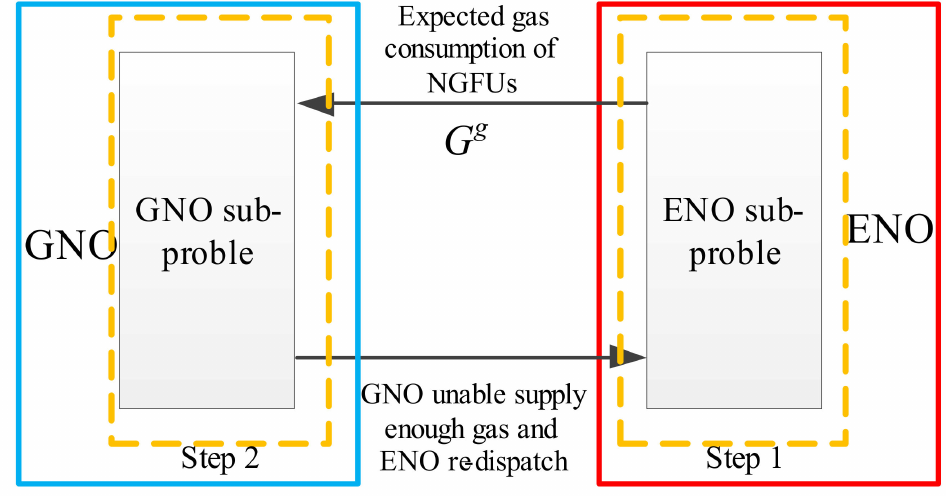
Figure 2. The structure of traditional DO.